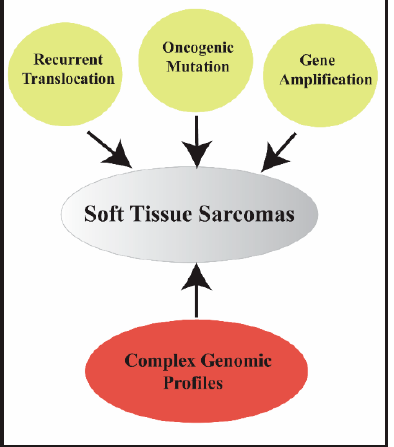
Figure 1. Types of molecular alterations in soft tissue sarcomas.